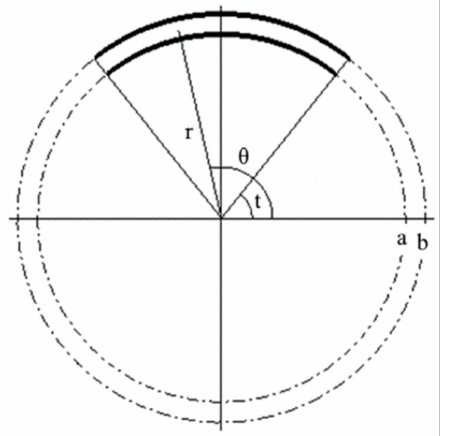
Figure 9. The circular area: t < θ < π − t ; a < r <